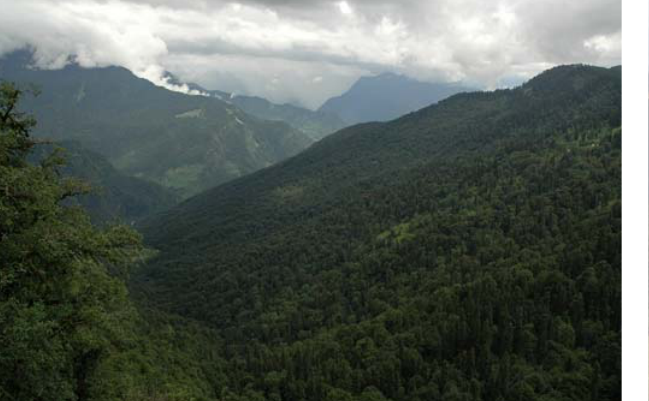
Image 5. Mussoorie Bush Bob, Pedesta masuriensis (under)